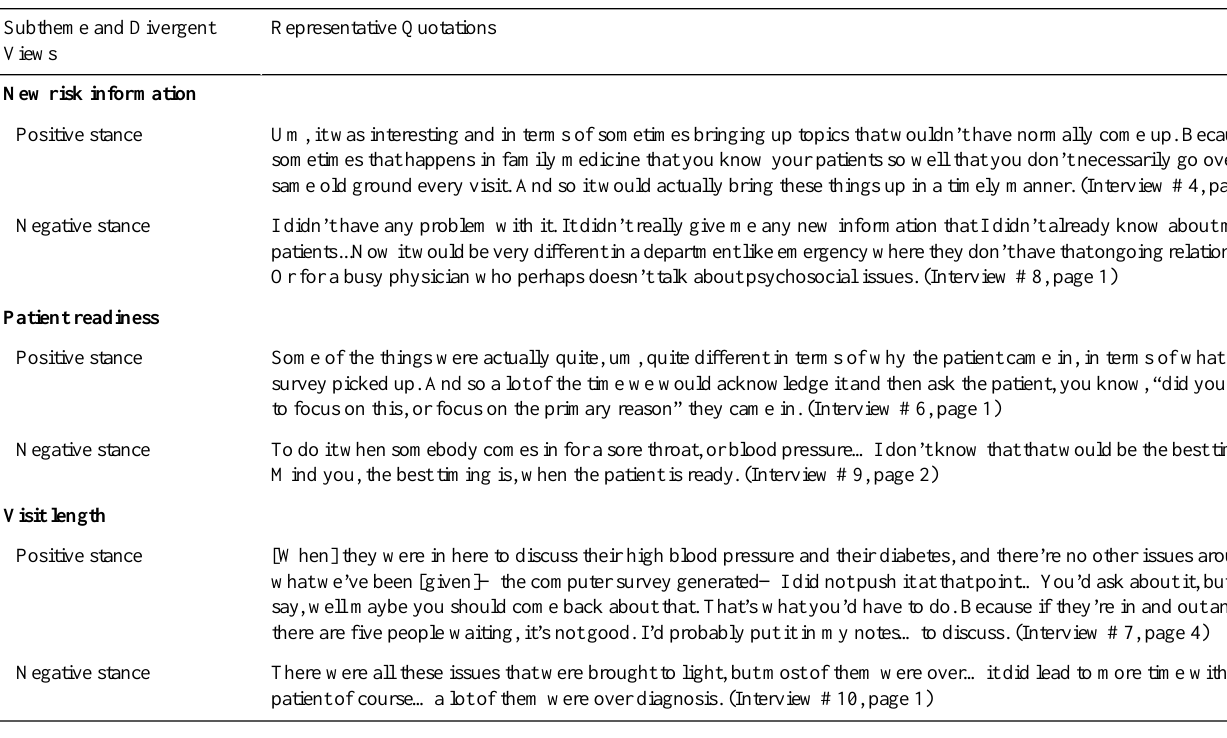
Table 2. Physician perceived concerns/challenges of the computer-assisted HRA